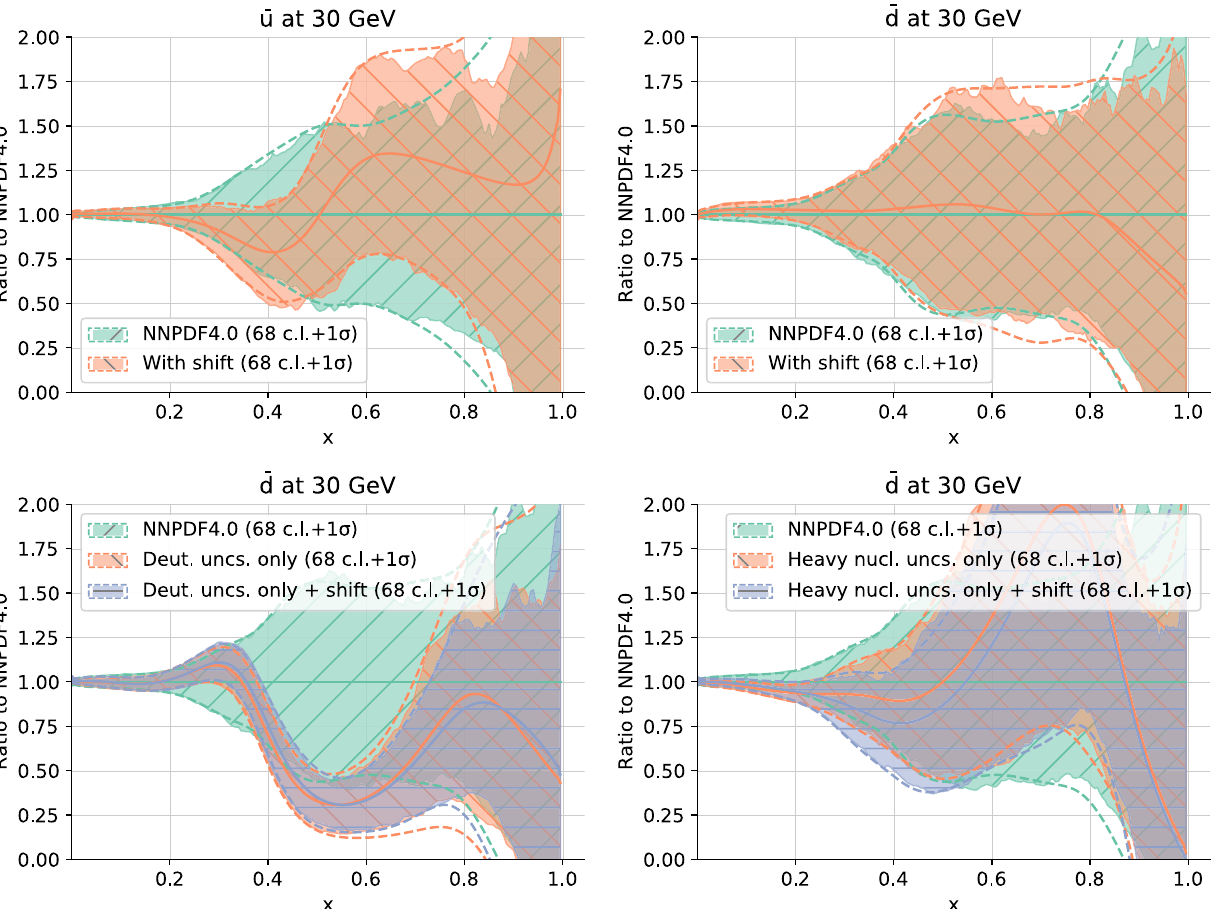
Fig. 55 Top: same as Fig. 54, but now with PDFs from the “Shift” set. Bottom: comparison to the baseline of the antidown PDF at Q = 30 from the “Deut Unc” and “Deut shift” sets (left) or from the “HeavyN unc” and the “HeavyN shift” sets (right)